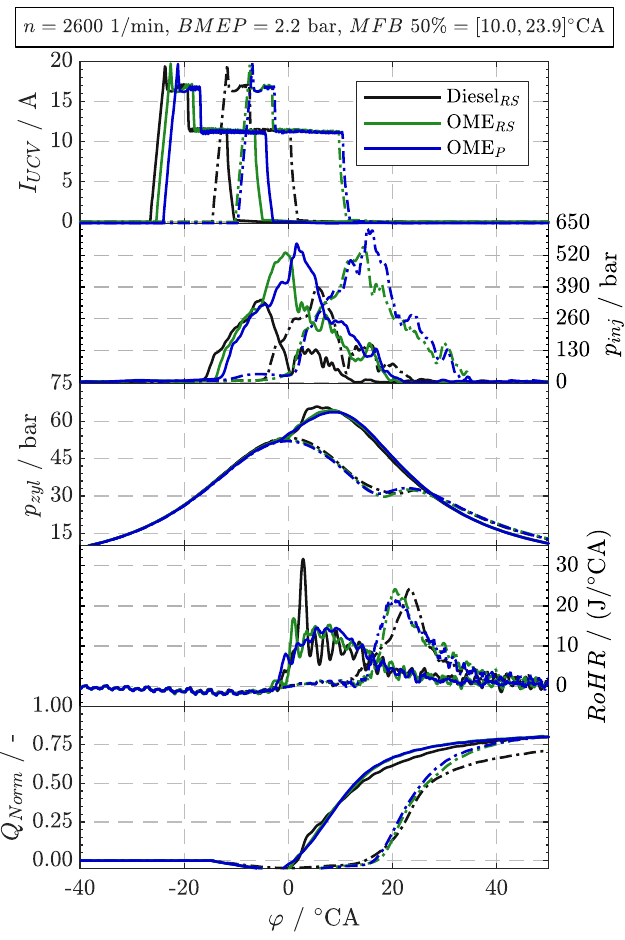
Figure 4. Drive current of high − pressure pump solenoid valve, pressure in injection line, cylinder pressure, rate of heat release and normalized released heat as a function of crank angle at two different MFB 50% timings for OP 1 and for two different nozzles in OME operation. Solid lines Table 4. Additional measurement values of OP 1 corresponding to Figure